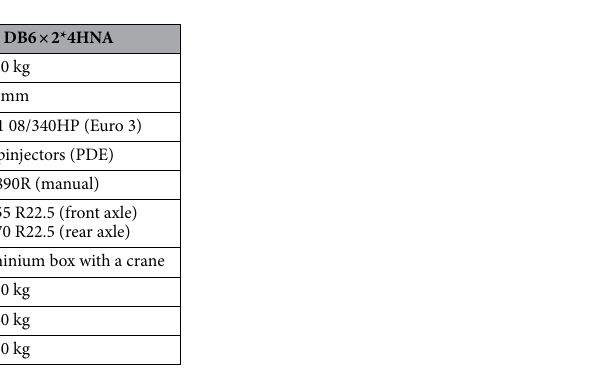
Table 2. The experimental truck specification (Source: